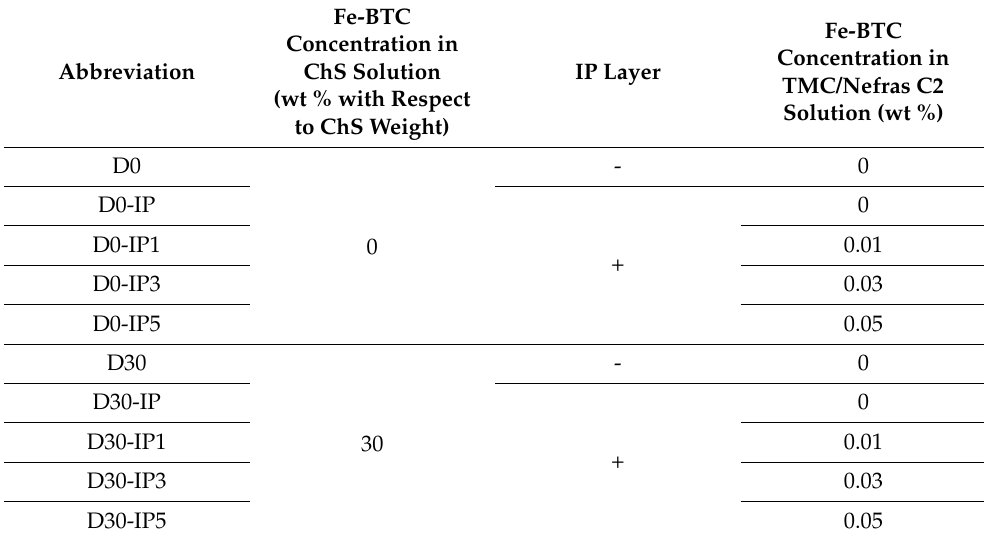
Table 1. TFC and TFN membrane abbreviations and preparation conditions (constant